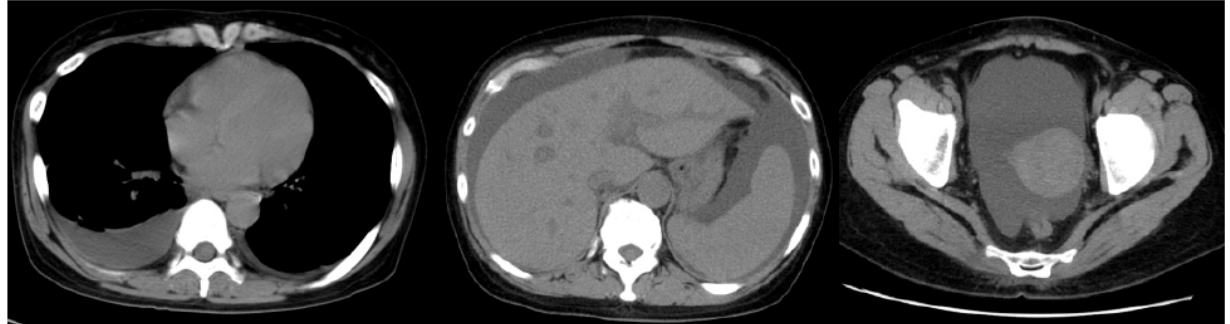
Figure 1. Chest and abdominal computed tomography (CT) images of the patient on transfer to our hospital. CT images show right-sided pleural effusion, ascites, and hepato-splenomegaly.